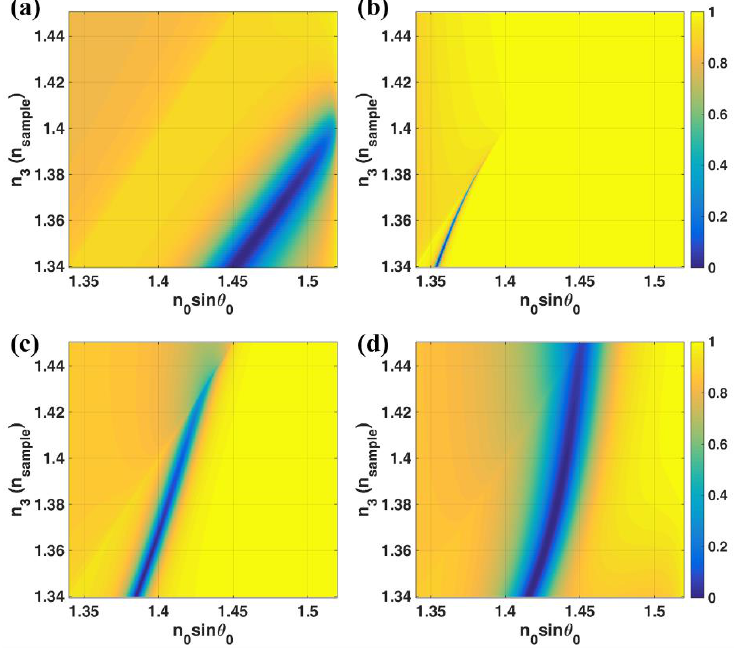
Figure 8. |r p | 2 responses when the sample refractive index n 3 changed from 1.34 to 1.45. ( a ) n 0 = n 1 = 1.52, n 2 = 0.18344 + 3.4332 i with d 2 = 48 nm and varying n 3 ; ( b ) n 0 = 1.52, n 1 = 1.34 with d 1 = 930 nm, n 2 = 0.18344 + 3.4332 i with d 2 = 20 nm and varying n 3 ; ( c ) n 0 = 1.52, n 1 = 1.34 with d 1 = 510 nm, n 2 = 0.18344 + 3.4332 i with d 2 = 40 nm and varying n 3 ; and ( d ) n 0 = 1.52, n 1 = 1.34 with d 1 = 3600 nm, n 2 = 0.18344 + 3.4332 i with d 2 = 60 nm and varying n 3